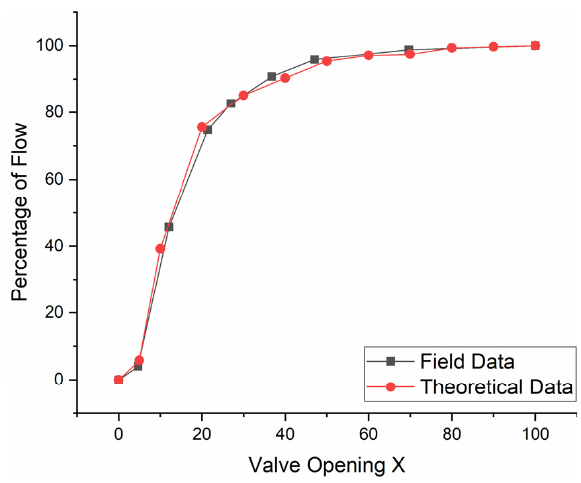
Figure 6. Comparison between theoretical model and field data.